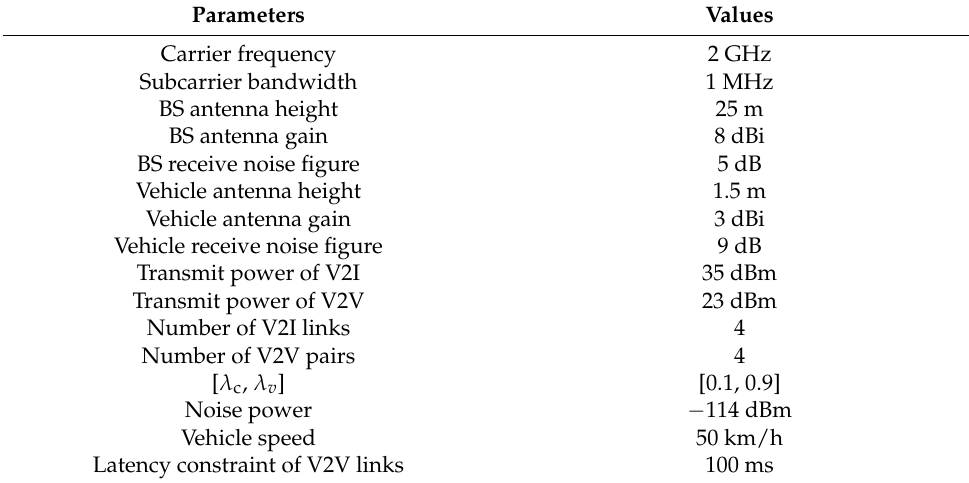
Table 1. Simulation parameters.